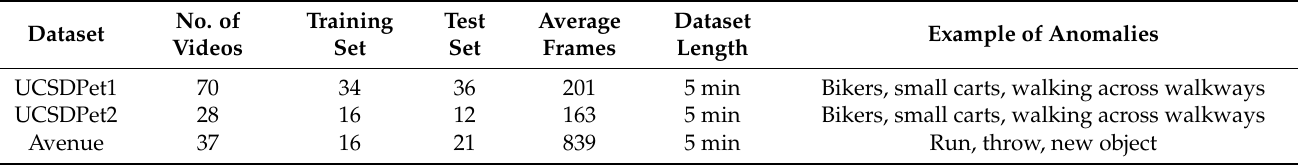
Table 3. The UCSD Pedestrian and Avenue dataset’s statistical information